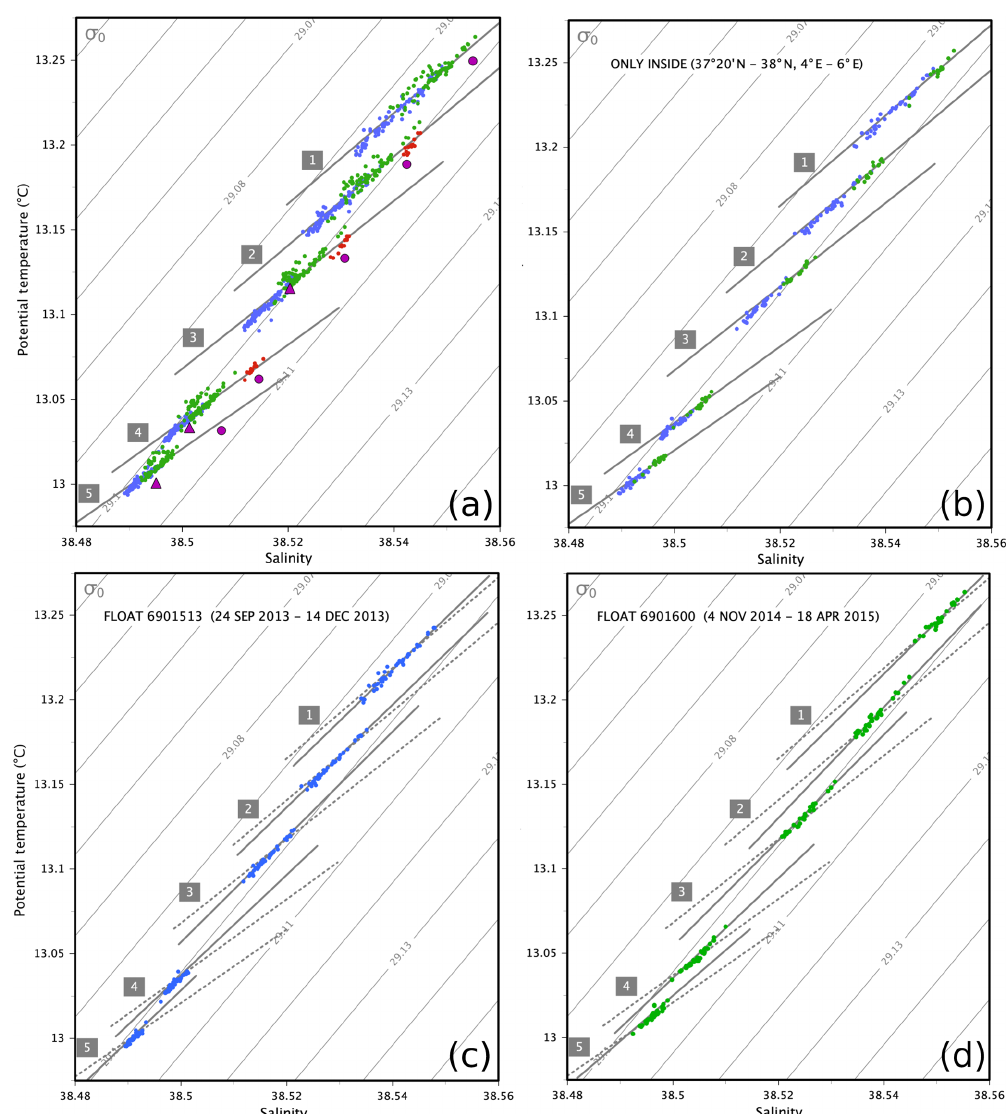
Figure 12. Temperature–salinity diagram of the layers. Colored dots correspond to the different floats in blue (6901513), green (6901600) and red (6902732); stations PEACETIME in 2017 are given by the purple circles, station SOMBA-GE in 2014 by the purple triangles. Layer numbers are similar to those in Table 4. The least-squares fit for each layer is indicated by the grey lines. Whole dataset (a) , selection inside the box (37 ◦ 20 (cid:48) –38 ◦(cid:48) N, 4 ◦ –6 ◦ E) (b) , and the two episodes (c, d) . The least-squares fit in (a) is reported in (c) and (d) with the dotted